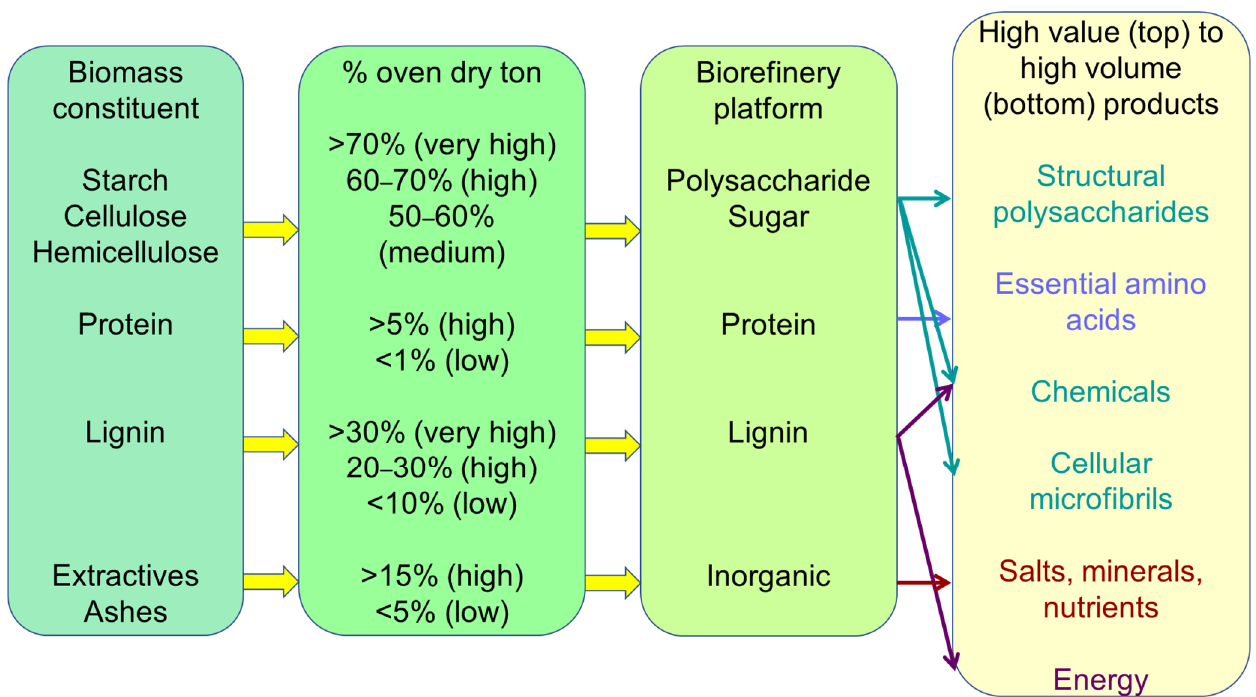
Figure 7. Integrated biorefinery/bioeconomy concept.